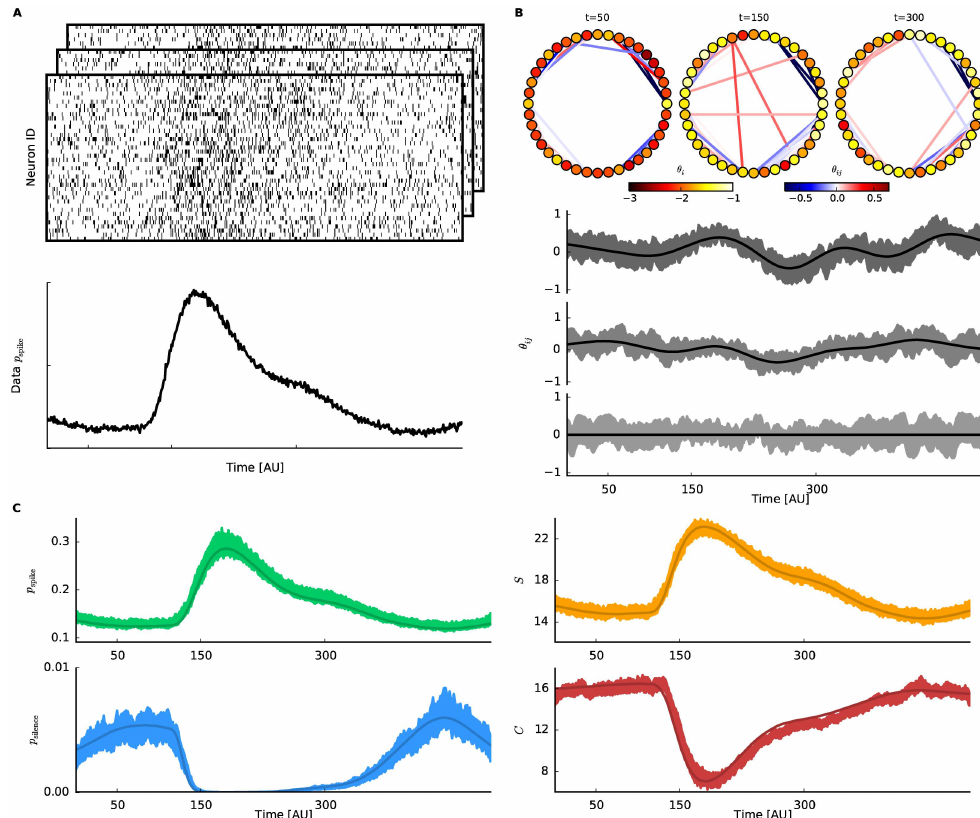
Fig 1. Approximate inference of dynamic neural interactions and macroscopic network properties. Analysis on simulatedspike data of 40 neurons. A Top: Simultaneous spikingactivity of 40 neurons that are repeatedlysimulated500 times (here only 3 trials are visualized). The data is sampledfrom a time-dependent model of a neuralpopulation(Eq 1). The time-varying parameters are chosen such that neurons’ spike probability resemblesevoked activity in responseto stimulus presentation to an animal. The neuralinteractionsare assumed to smoothly changeirrespective of the firing rates. See the main text for details. Bottom: Empirical spike probability over time, averagedover trials and neurons. B Top: Estimated network states at t = 50, 150, 300 by the pseudolikelihood-Bethe approximation method. Neuronsare represented by nodes whosecolors respectively indicate a value of the smoothedestimate of y t (for i = 1, ... , 40). Links are color-coded accordingto estimated i strength of the interaction y t betweenconnectednodes (positiveor negativeinteractionsare marked in red or blue, ij respectively). Only significantedgesare displayed, where the corresponding y t has a 98% credibleintervalthat ij does not include0. Bottom: Dynamics of 3 exemplary interaction parameters, y t . The lines denotethe groundtruth ij from which the binary data are sampled.The shaded areas are 98% credibleintervals. C Estimated population rate (top left). Probabilitythat all neuronsare silent (bottom left). Entropy (top right) and heat capacity (bottom right) of the neuralpopulation.In all panels,shaded areas indicate1% and 99% quantiles obtainedby resampling the natural parametersfrom the fitted smootheddistribution.Solid lines represent groundtruth computedfrom the underlyingnetwork